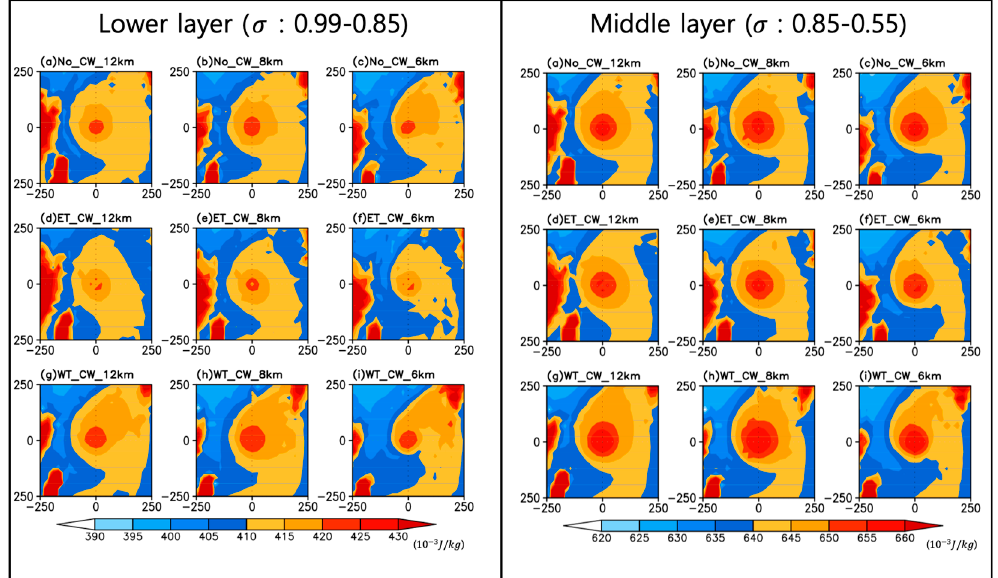
Figure 8. The spatial pattern of the vertical averaged MSE during 48–60 h in ( a ) No_CW_12 km, ( b ) No_CW_8 km, ( c ) No_CW_6 km, ( d ) ET_CW_12 km, ( e ) ET_CW_8 km, ( f ) ET_CW_6 km, ( g ) WT_CW_12 km, ( h ) WT_CW_8 km and ( i ) WT_CW_6 km. left panel is lower layer(0.99 to 0.85 sigma level) and right panel is middle layer(0.85 to 0.55 sigma level).